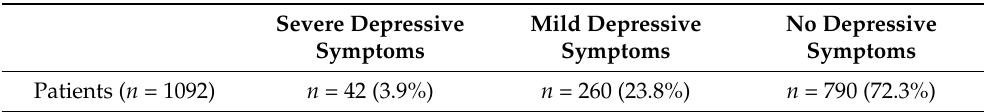
Figure 2. Distribution of depressive symptoms in older patients scheduled for comprehensive geriatric care. ‘GDS’ = Geriatric Depression Scale. ‘CGC’ = comprehensive geriatric care. Table 1. Distribution of depressive symptoms among older adults treated with comprehensive geriatric care (n = 1092).